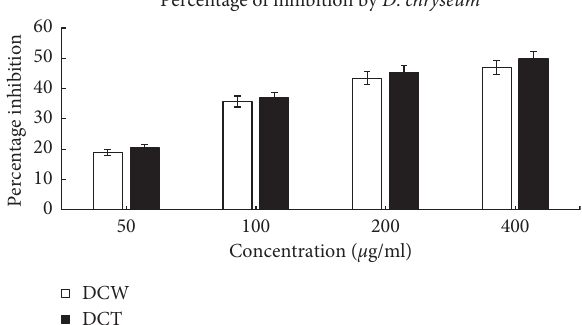
Figure 2: Percentage of inhibition of HeLa cell proliferation by D. chryseum derived from DCW and DCT